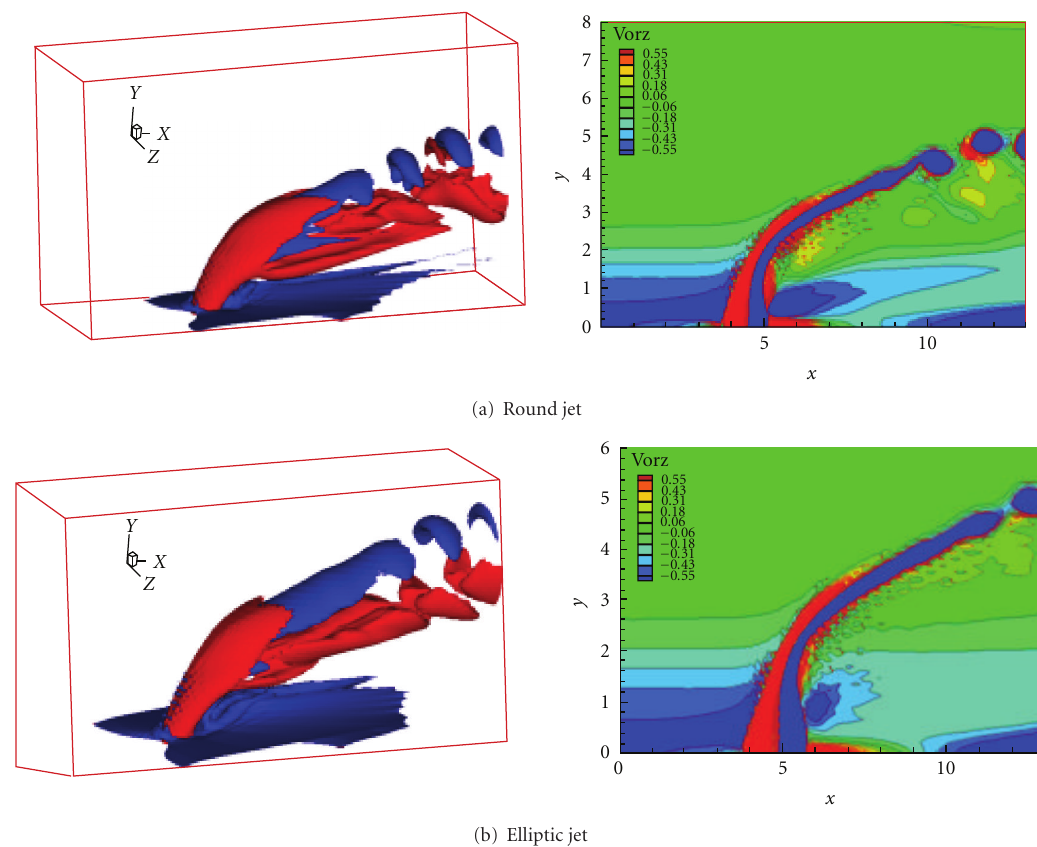
Figure 4: Simulated isosurfaces of the spanwise vorticity ( ω z = 0 . 5, u 2 / D 2 , red positive and blue negative) (left) and vorticity contours at midplane